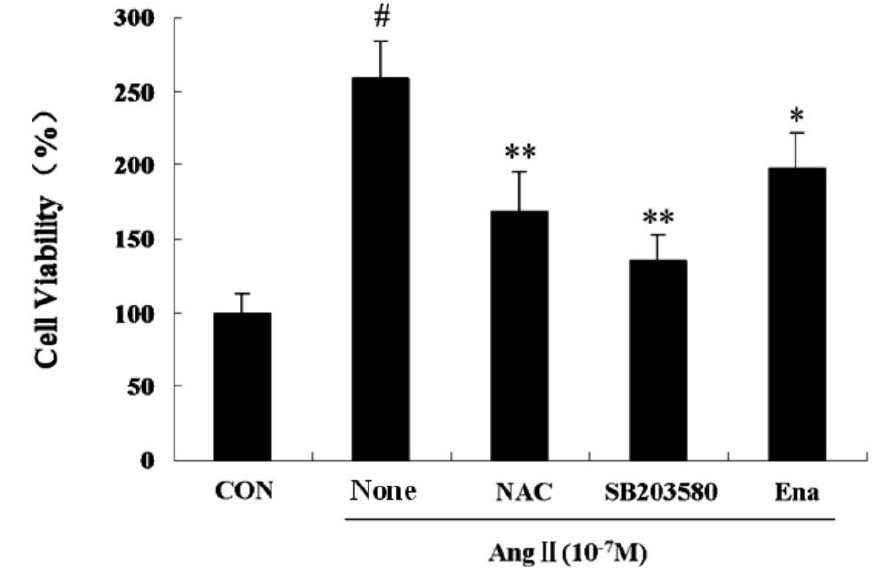
Figure 1. Influence of Ang II on rat cardiac fibroblast proliferation as measured by BrdU incorporation. Cells were grown in the absence or presence of Ang II (10 − 7 M; Ang II ) and coincubated with the ACE inhibitor enalaprilat (10 − 6 M, Ena. ), antioxidant NAC (10 − 2 M, 30 minutes prior to Ang II administration), p38MAPK inhibitor, SB203580 (10 − 7 M, 30 minutes prior to Ang II administration) for 24 hours. Bars represent the DNA synthesis as measured by BrdU incorporation with SEM. Activity is shown relative to cells treated with vehicle alone ( C ). Data are presented as mean ± S.E.M. # P < 0.001 vs. Control; * P < 0.05, ** P < 0.01 vs. Ang